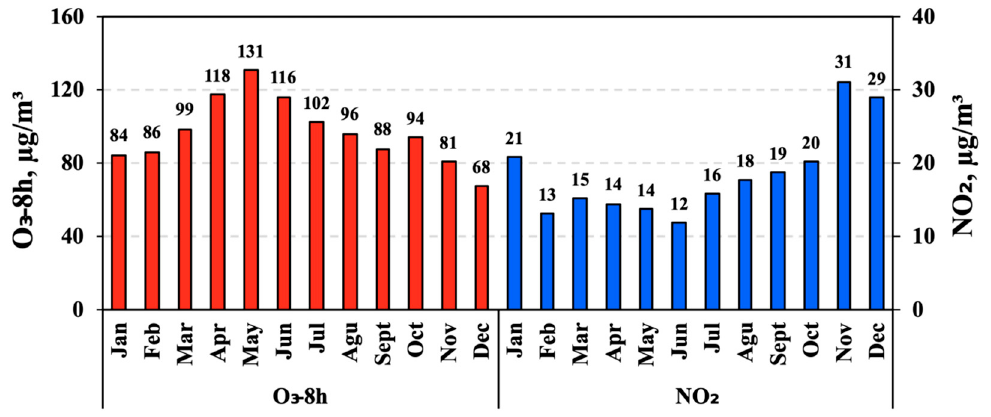
Figure 1. Profiles of maximum 8 h daily average ozone (O 3 -MDA-8h) in 2019 and NO 2 concentrations in Lhasa.